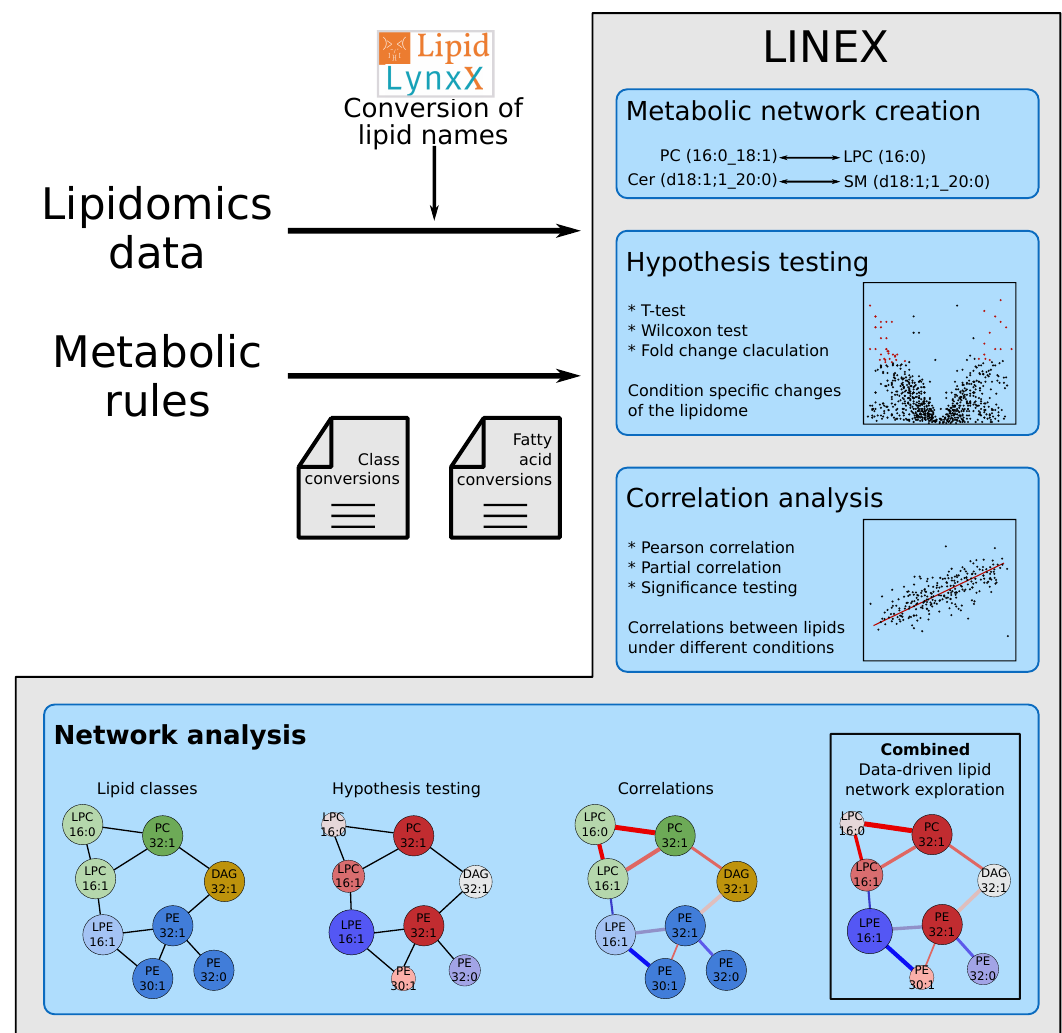
Figure 1. Workflow of the LINEX approach. Lipidomics data and optionally customized metabolic rules are uploaded by the user. The data are used to generate an experiment-specific lipid network, which can be visualized together with statistical measures such as correlation and fold